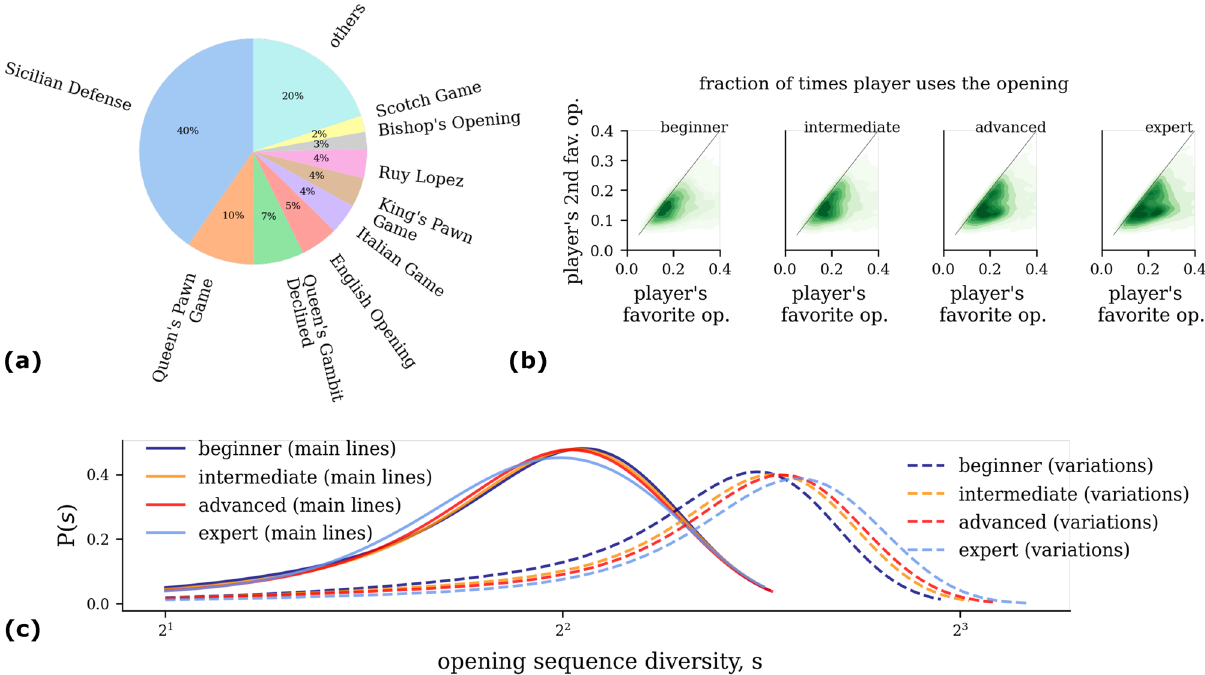
Figure 3. Diversity and specialization in the opening sequence of moves is governed by skill level. ( a ) Top 9 favorite openings among all players. ( b ) Fraction of times players use their top-2 favourite openings. Different panels correspond to different skill levels. Density plots are used for better visualization. Expert players play more often their favorite opening sequence as compared to beginners. ( c ) Distribution of diversity (entropy) of openings calculated for players of four different skill levels. Main lines and the variations are respectively depicted as solid and dashed